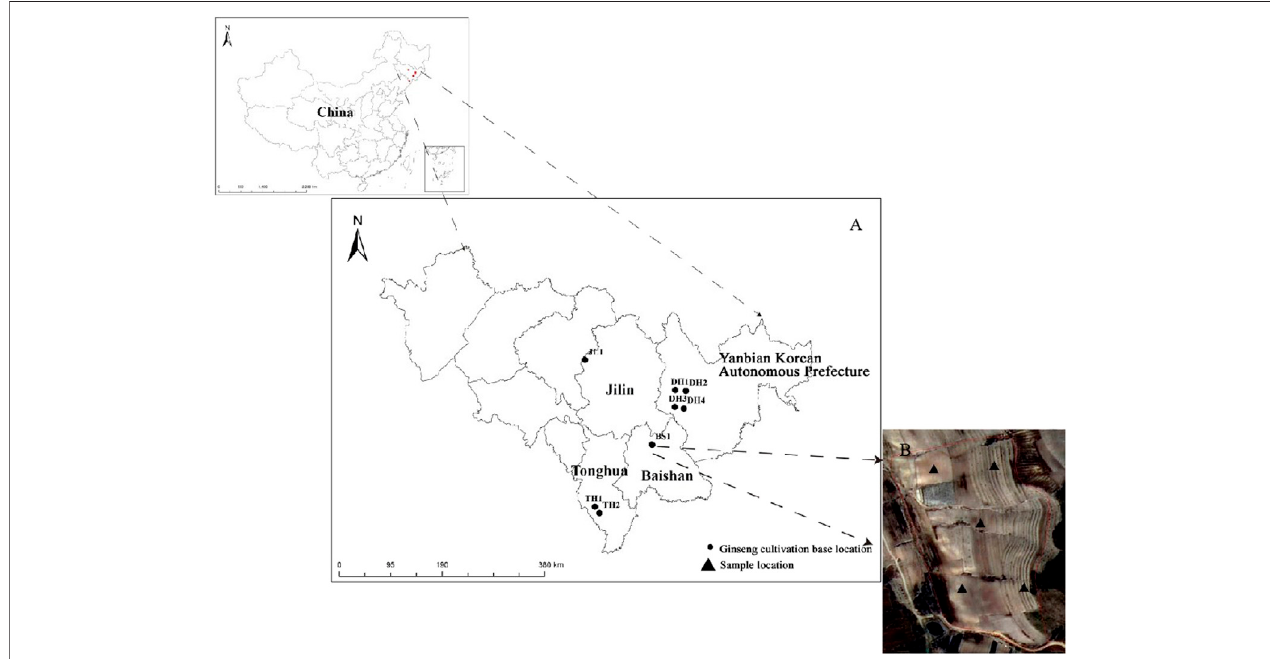
FIGURE 1 | Map showing the eight ginseng cultivation bases of Jilin Province, China. (A) Research areas within Jilin Province. (B) Satellite imagery showing the ginsengsamplinglayoutattheBS1siteasanexample.Theginsengcultivation basenameswereBS1,DH1,DH2,DH3,DH4,JL1,TH1,andTH2(BS,Baishancity;DH, Dunhua city; JL, Jilin city; TH, Tonghua